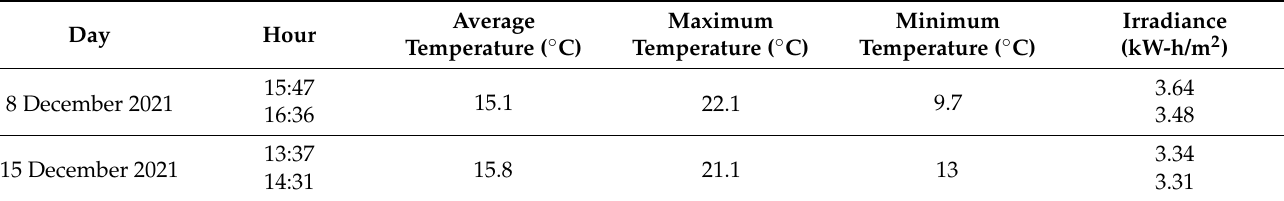
Table 2. Temperature and radiation parameters (commuting days).